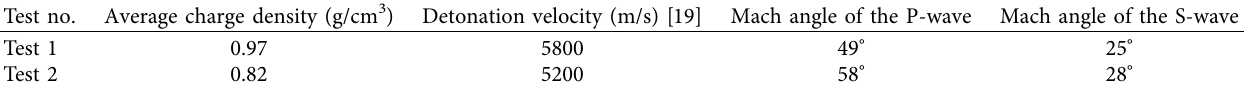
Table 3: Charge parameters.